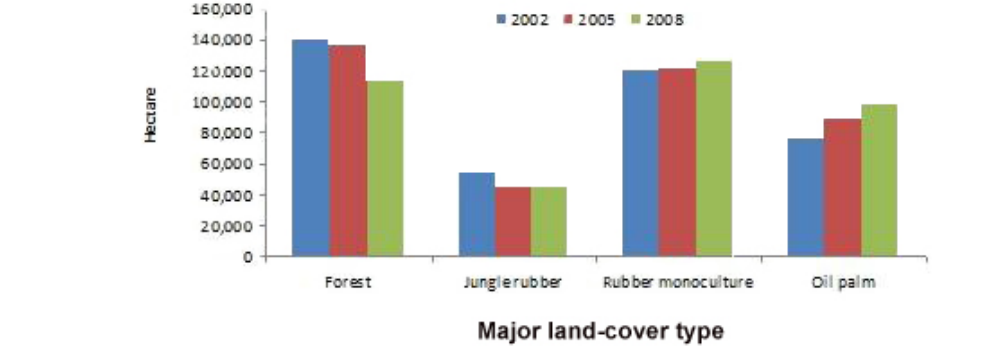
Fig. 1. Land-cover change between 2002 and 2008 in Jambi Province (Source: Ekadinata et al.